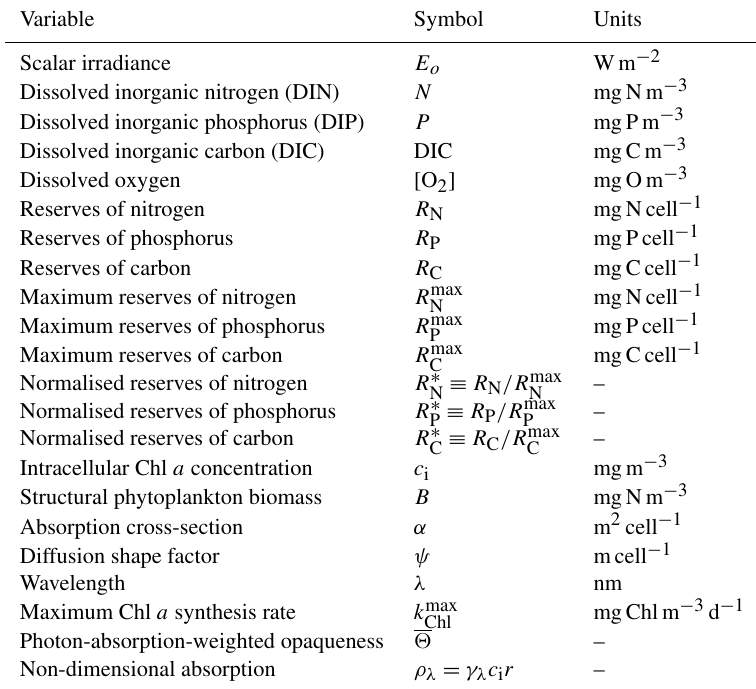
Table 4. State and derived variables for the microalgae growth model. DIN is given by the sum of nitrate and ammonium concentrations, [NO 3 ]+[NH 4